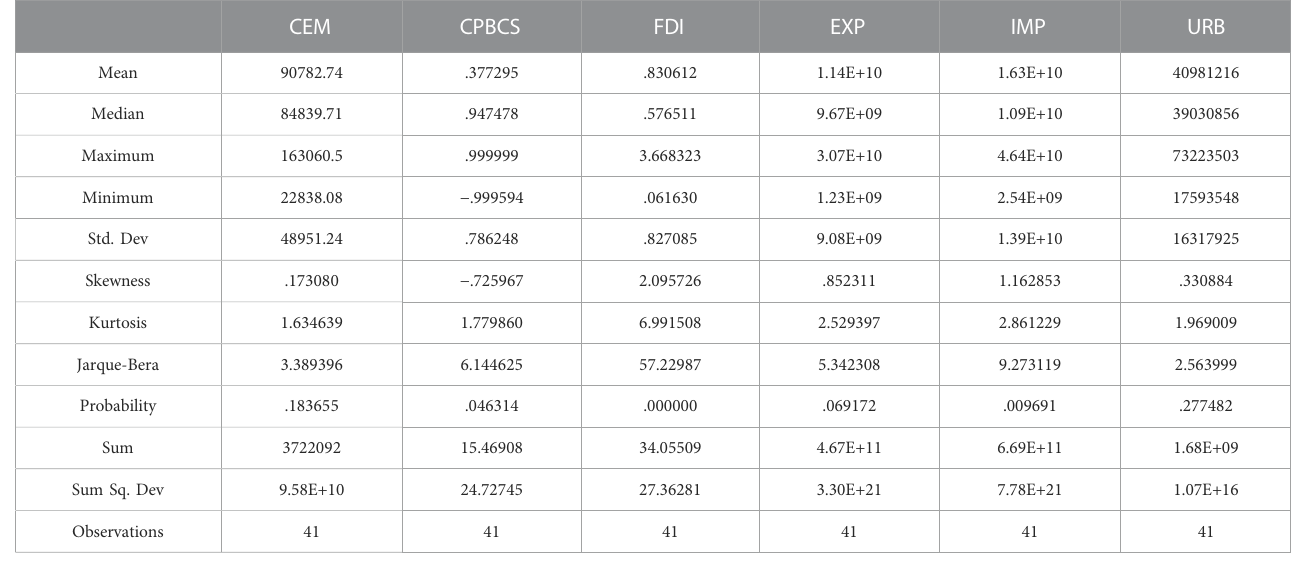
TABLE 1 Descriptive statistics of original series.